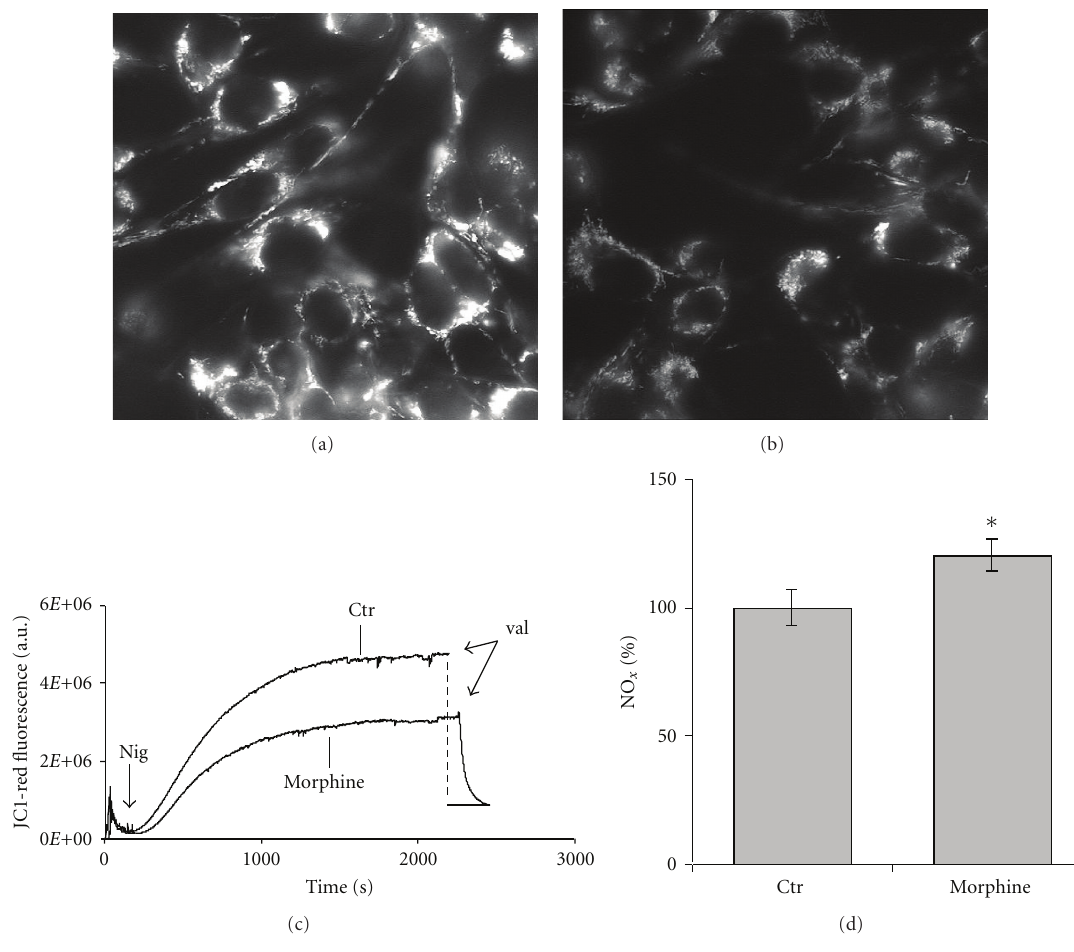
Figure 2: Morphine-induced mitochondrial membrane potential and NO x changes in Glioma cells. Fluorescence microscopy : control cells (a), 20 nM morphine incubated for 24h (b). Mitochondrial membrane potential ( ΔΨ ) was probed using Rhodamine123; the dye is electrophoretically accumulated by the cell mitochondria. Bulk fluorescence (c). Control (ctr) versus morphine-treated (morphine) cells, assayed in air-equilibrated medium and in the presence of 2 μ M ouabain and 0.4 μ M JC-1; after signal stabilization, 0.6 μ M nigericin is added and fluorescence changes followed over time. Addition of valinomycin abolishes the membrane potential. Excitation and emission wavelength, 575 nm and 590nm, respectively. Nitrite accumulation (d). The release of NO x (nitrite and nitrate) in the medium and during incubation with morphine was assessed spectrophotometrically by the Griess reaction; results expressed as percentage of control cells ( c tr). ∗ P < 0,05. Modified from